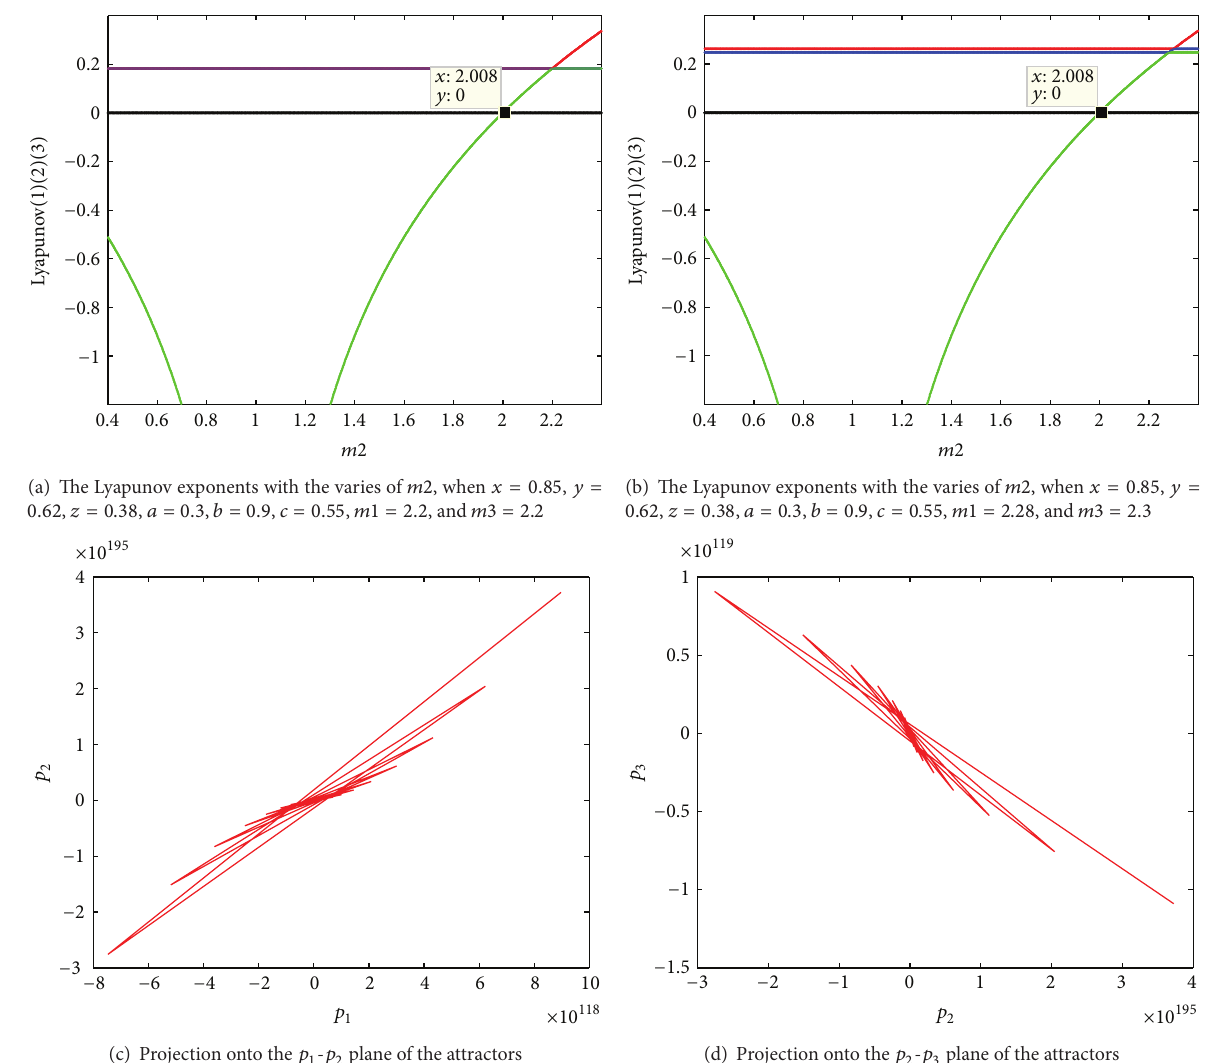
Figure 26: The Lyapunov exponents with the varies of parameters 𝑎 ( 𝑎 ∈ [1,2.6] ) and 𝑏 ( 𝑏 ∈ [12, 22]) when the step length is 0.001.